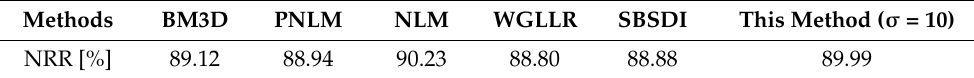
Table 5. The NRRs of the proposed E2PGICMA